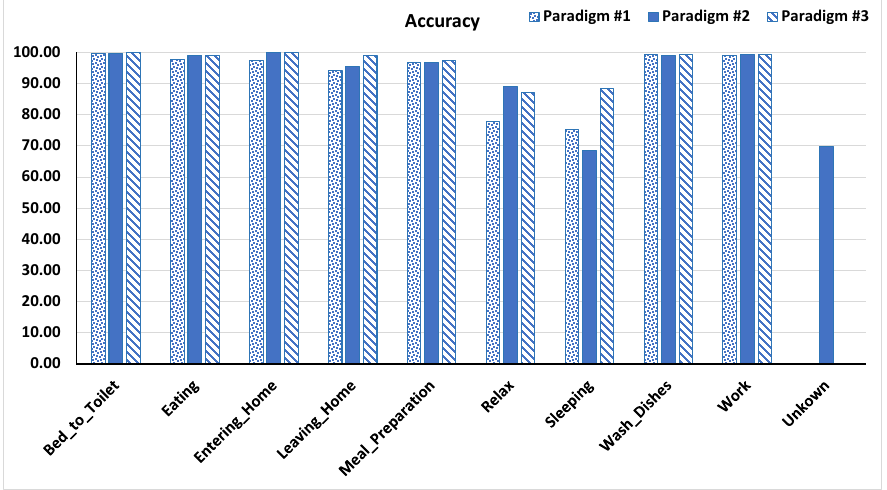
Figure 8. Accuracy values of the proposed paradigms. Note the improvement of Sleeping recognition with paradigm #3, which characterizes the encapsulating activities. This achieves some degree of distinction from other idle-tended activities such as Relax .